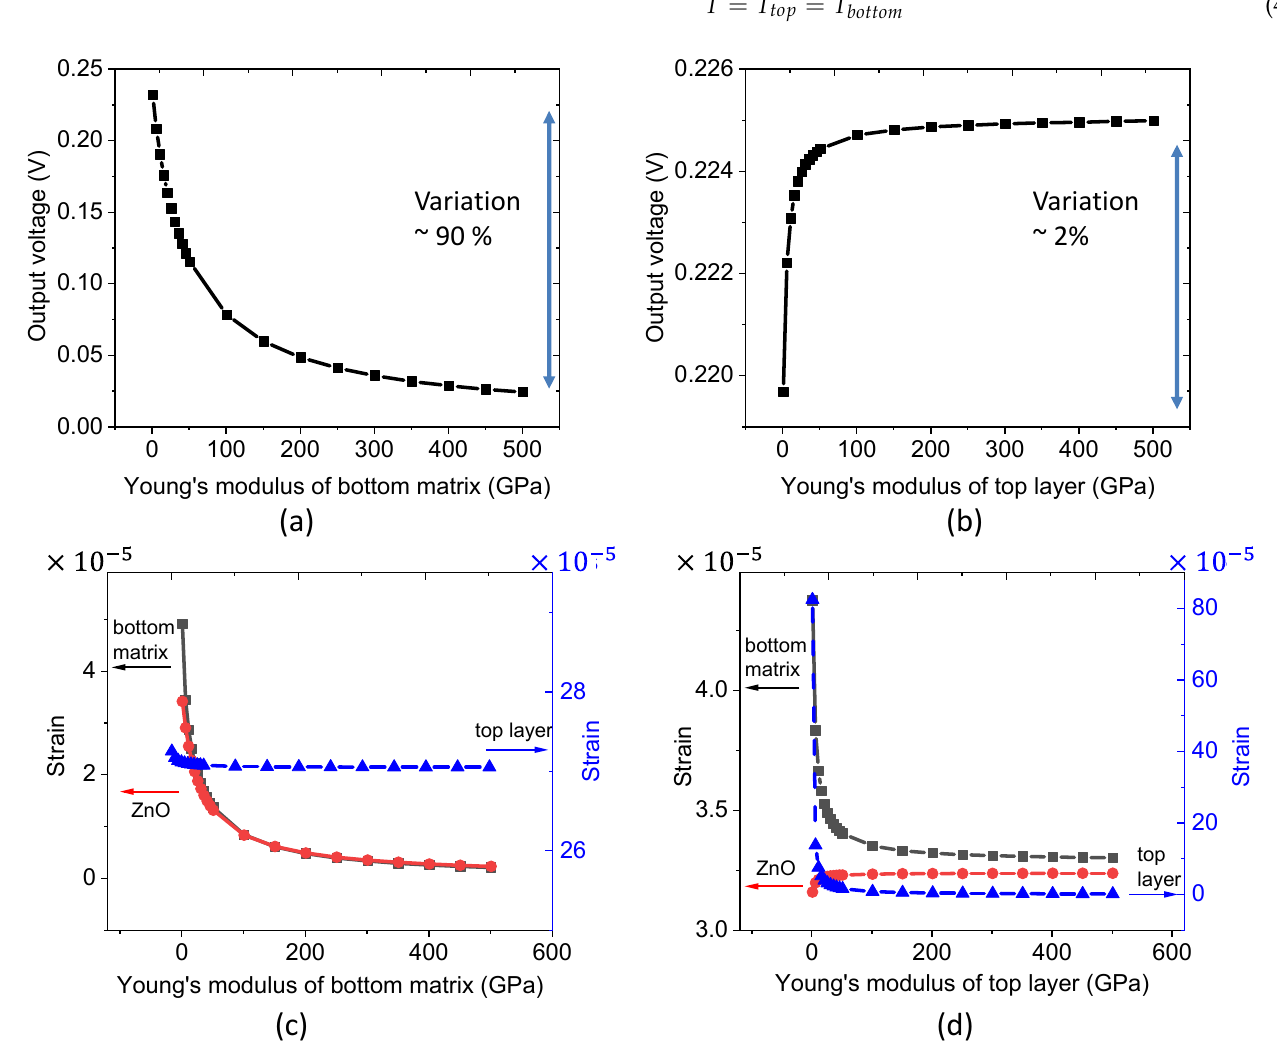
Figure 5. Effect of Young’s modulus of the bottom matrix and the top layer, respectively on: ( a , b ) the generated output voltage; ( c , d ) the resulting strain along the stress direction of different layers.